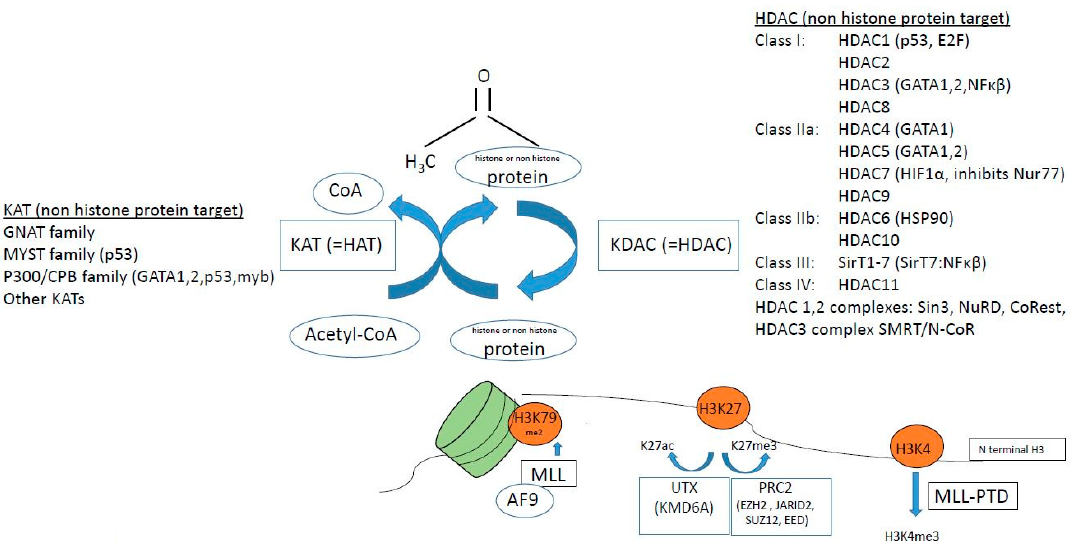
Figure 4. Factors associated with histone or non-histone protein lysine acetylation/methylation, affected in hematological malignancies. In brackets are listed non-histone targets of HAT (KAT) and histone deacetylases (HDACs). See text for details on how these epigenetic factors are associated with myeloid malignancies.